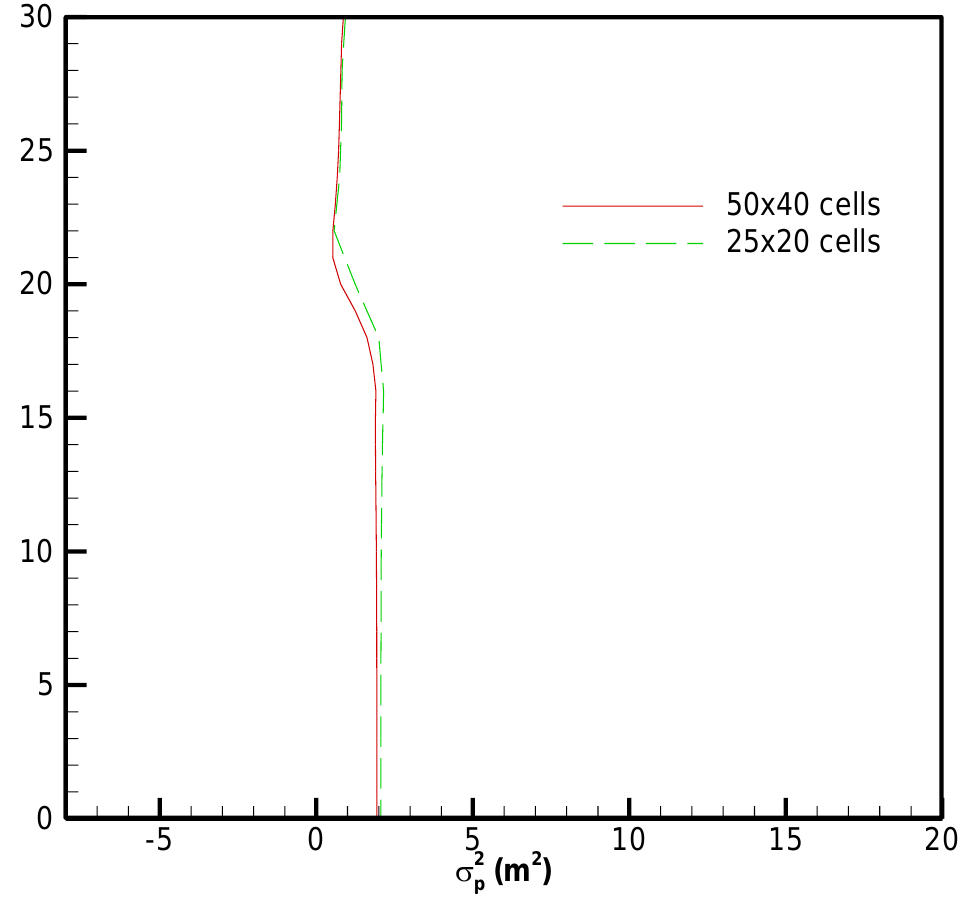
Figure 8. Comparison of variance of pressure head along section 1-1′ obtained by first-order analysis using two different grid densities.